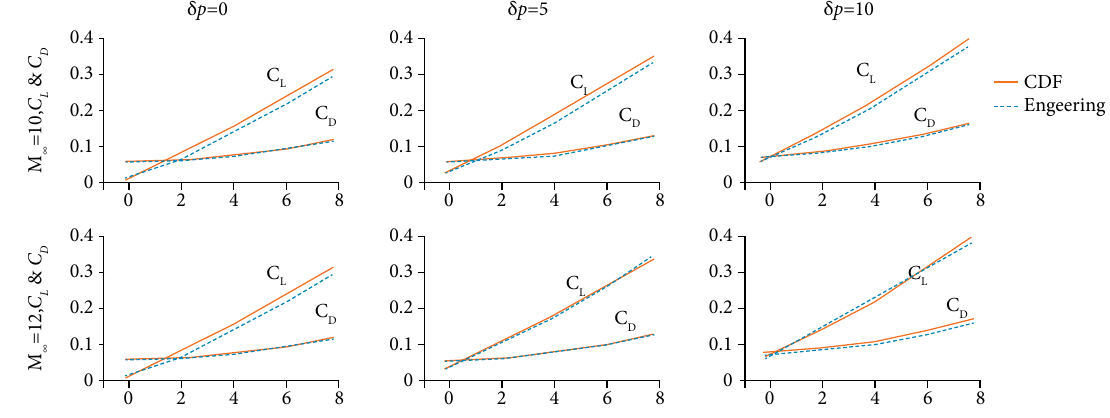
Figure 4. Lift and drag curve of PRAHV for contrast